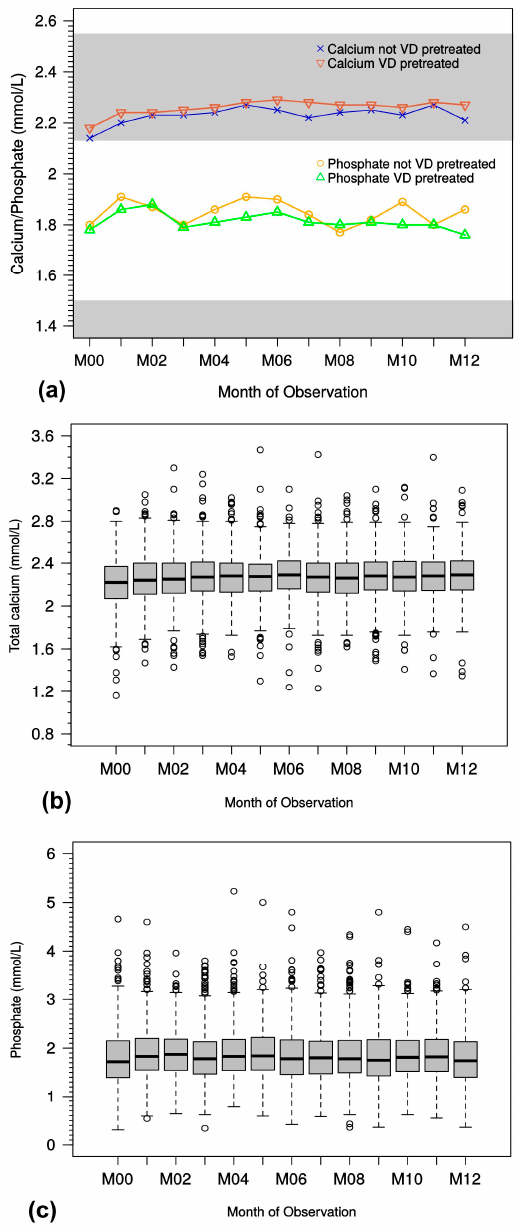
Figure 7. ( a ) Course of median total serum calcium and phosphate levels. Differently colored background areas indicate normal serum levels for either electrolyte. ( b ) Course of total serum calcium levels. Box-whisker-plot shows median and interquartile range with outliers (open circles); ( c ) Course of total serum phosphate levels. Box-whisker plot shows median and interquartile range with outliers (open circles). M, month; VD, vitamin D.